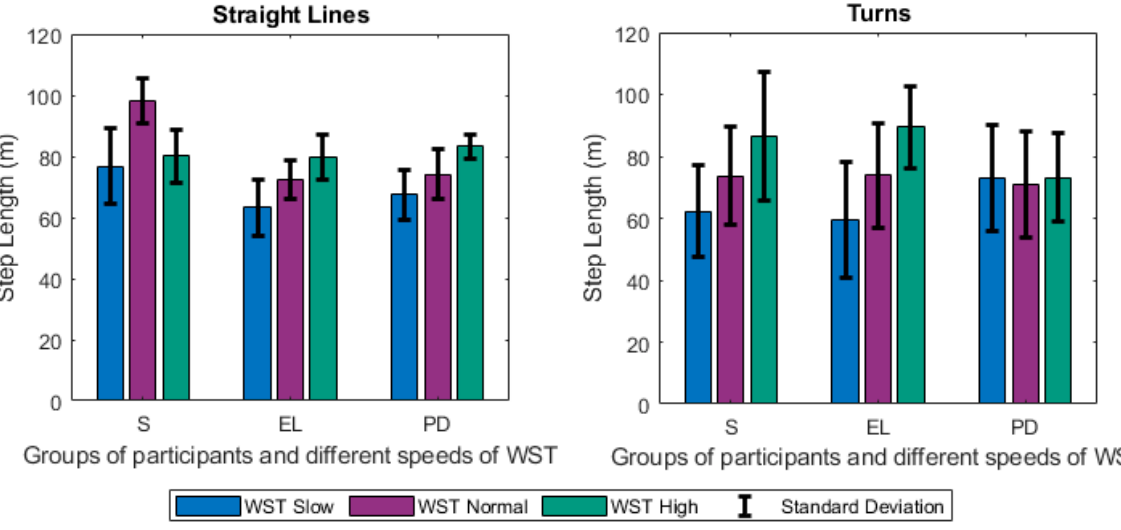
Figure 5. Changes of the Step Length (m) for Straight Lines and Turns (mean values along with standard deviations) between the different groups of participants (S, EL, PD) and the different speeds of the WST test (slow, normal, high).